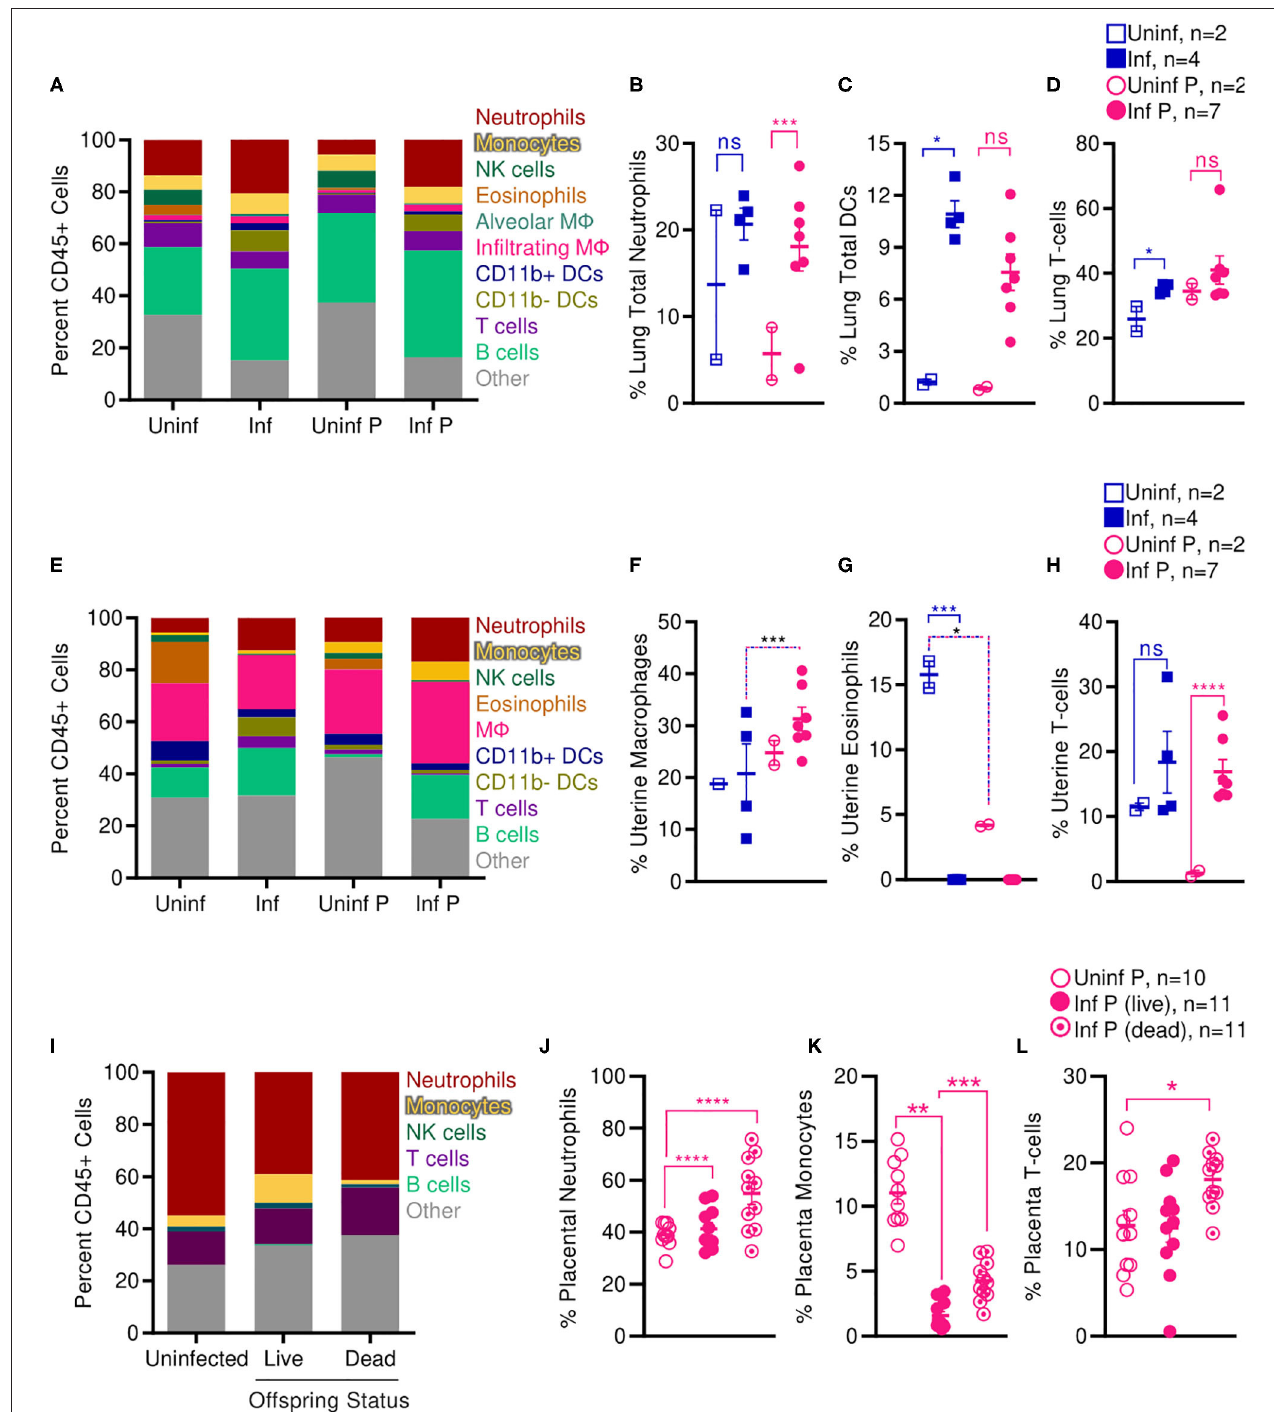
FIGURE 7 | Pregnant mice show increased pulmonary T cells, uterine macrophages, and placental neutrophils following influenza infection. Immune cell populations were determined from total CD45 + cells by flow cytometry in (A–D) lungs, (E–H) uteruses, and (I–L) placenta isolated from infected and uninfected pregnant and non-pregnant animals. Cell frequencies were analyzed via Two-way ANOVA using Sidak correction for multiple comparisons. Error bars represent Standard Error of Mean (SEM) for all graphs. * p < 0.05; ** p < 0.01; *** p < 0.001; **** p < 0.0001.